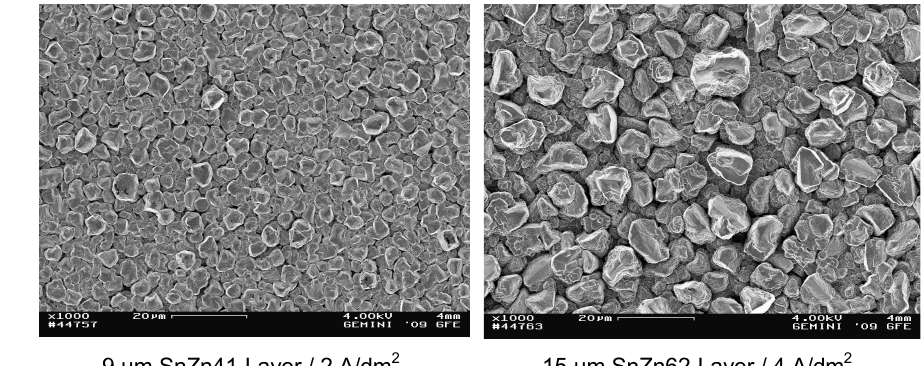
9 µm SnZn41-Layer / 2 A/dm 2 15 µm SnZn62-Layer / 4 A/dm 2 Figure 10 – SEM analysis of the Sn-Zn layers obtained from an electrolyte with 0.05 mol/l Sn; 0.2 mol/l Zn; 0.625 mol/l K4P2O7 and 1 g/l Gelatine (60°C; pH=9.3; 20 min); magnification: 1.000 x Рис . 10 – SEM анализ Sn-Zn слоев , полученных из электролита с 0.05 mol/l Sn; 0.2 mol/l Zn; 0,625 mol/l K4P2O7 и 1 g/l желатина (60°C; pH=9.3; 20 мин .); масштаб увеличения : 1.000 x Slika 10 – SEM analiza Sn-Zn slojeva dobijenih iz elektrolita sa 0.05mol/l Sn; 0.2 mol/l Zn; 0,625 mol/l K4P2O7 i 1 g/l želatina (60°C; pH=9.3; 20 min.); uve ć anje: 1.000